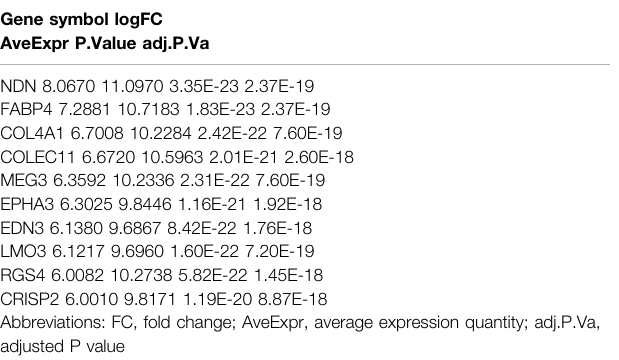
TABLE 2 | Top ten upregulated genes of DEGs. Gene symbol logFC AveExpr P.Value